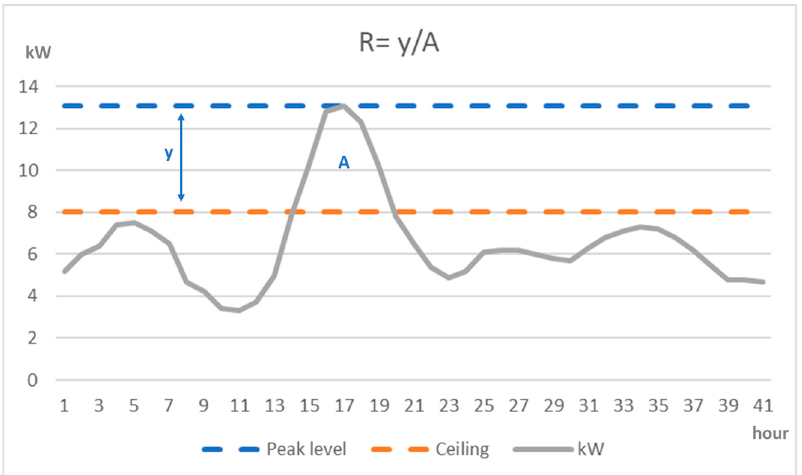
Figure 1. Consumption curve with high, pointed peaks that require a relatively high power density compared to energy density; R is high. (R = y/A).